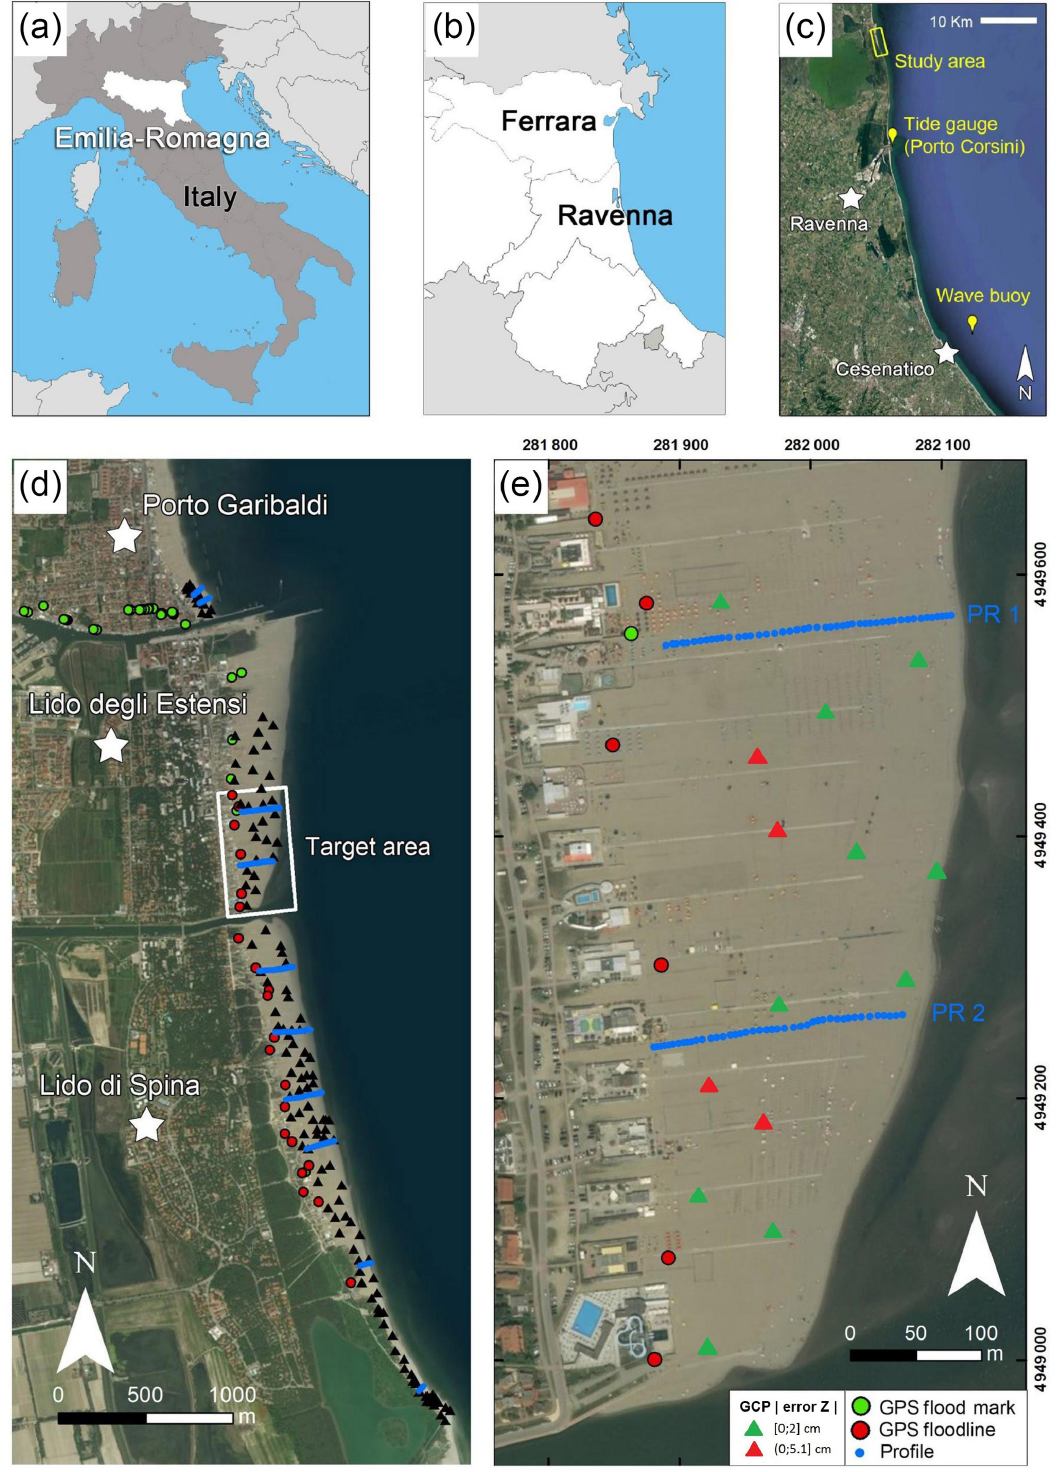
Figure 1. Field study site locations: (a) Emilia–Romagna region, (b) coastal regional domain, (c) locations of the nearest tide gauge and wave buoy, (d) pilot case study site, and (e) target area for data